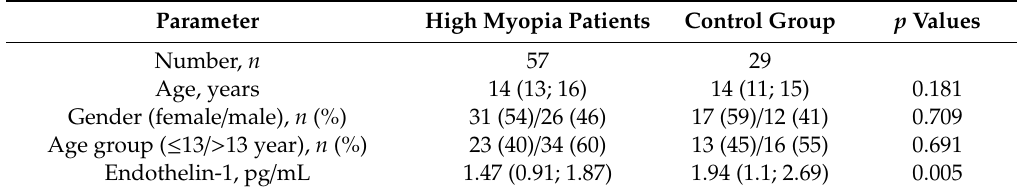
Table 1. Basic characteristics and serum endothelin-1 concentration in children and adolescents with high myopia and controls.